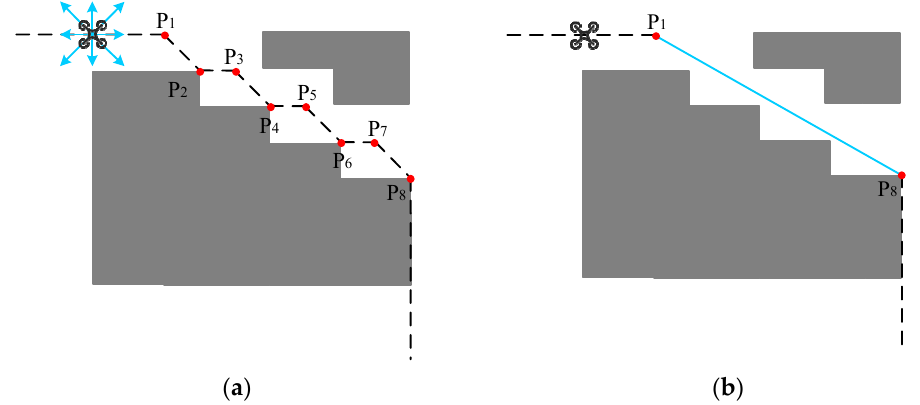
Figure 2. Air-route smoothing result. ( a ) Before smoothing. ( b ) After smoothing.